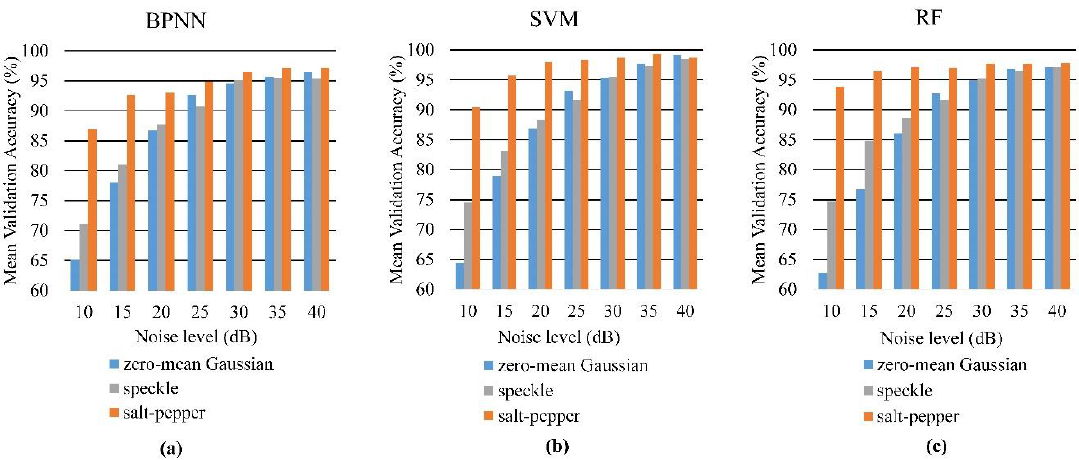
Figure 4. Mean validation accuracy trends of ( a ) neural network, ( b ) support vector machine, and ( c ) random forest classifier in relation to different noise levels and types.